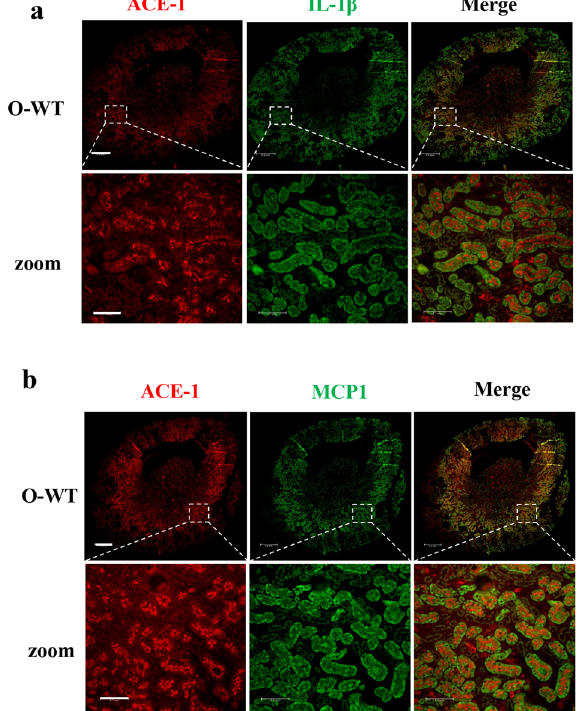
Fig. 3 Cellular co-localization of ACE-1/IL-1 β and ACE-1/MCP1 in the kidney. Central transverse sections were prepared from old wild type (O-WT) female mice and subjected to immuno fl uorescence staining of a ACE-1 (red) and IL-1 β (green) or b ACE-1 (red) and MCP1 (green). Enlarged images were selected from outer medulla. Scale bar = 0.5 mm for upper panels in ( a , b ) and 0.1 mm for lower panels in ( a , b ).